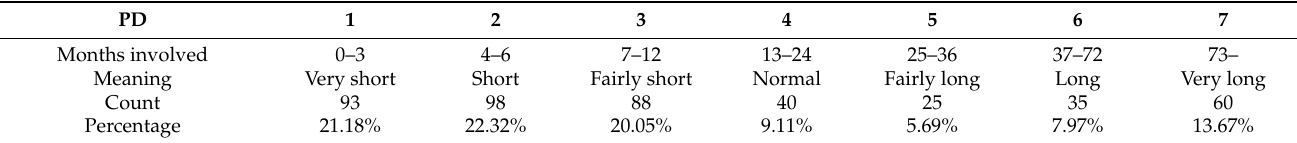
Table 4. Descriptive statistics for the dependent variable.